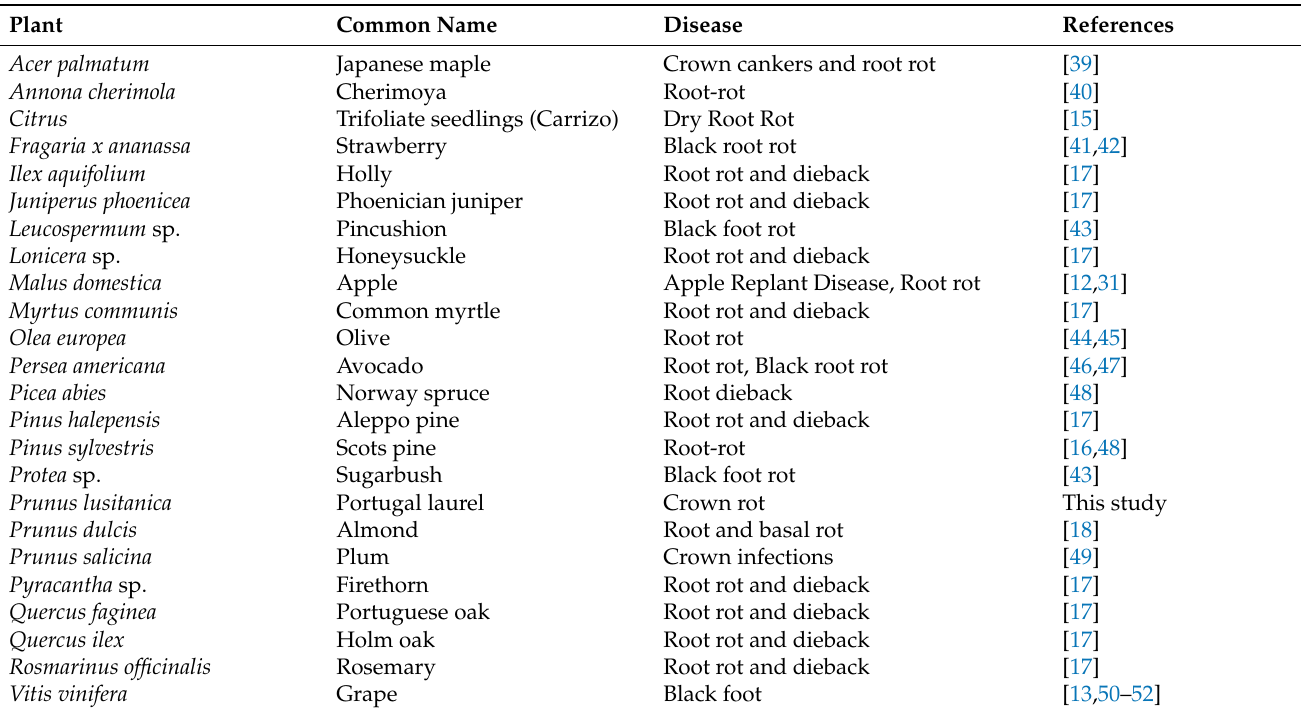
Table 1. List of plants on which the presence of the fungal pathogen Dactylonectria macrodidyma has been